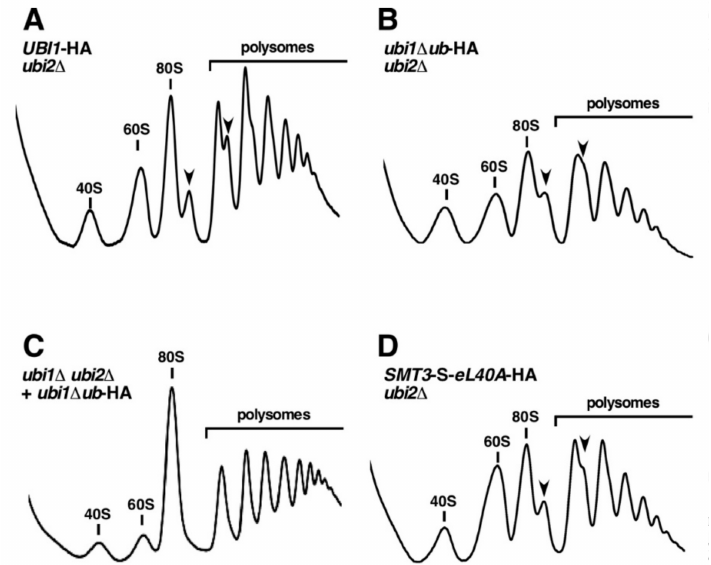
Figure 5. The genomically integrated ubi1 ∆ ub -HA and SMT3-S-eL40A -HA alleles a ff ect the synthesis and function of 60S r-subunits. Strains SMY256 ( UBI1 -HA ubi2 ∆ ) ( A ), SMY257 ( ubi1 ∆ ub -HA ubi2 ∆ ) ( B ), SMY215 [YCplac111- ubi1 ∆ ub -HA] ( ubi1 ∆ ubi2 ∆ + ubi1 ∆ ub -HA) ( C ), and SMY258 ( SMT3-S-eL40A -HA ubi2 ∆ ) ( D ) were grown in YPD medium at 30 ◦ C to an OD 600 of about 0.8. Cell extracts were prepared and 10 A 260 units of each extract were resolved in 7–50% sucrose gradients. The A 254 was continuously measured. Sedimentation is from left to right. The peaks of free 40S and 60S r-subunits, vacant 80S ribosomes / monosomes and polysomes are indicated. Half-mer polysomes are labeled by